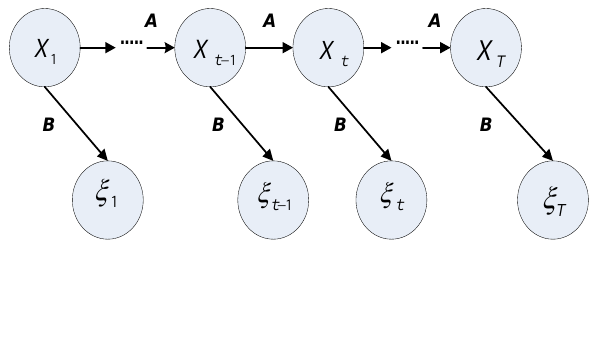
Figure 1. Hidden Markov